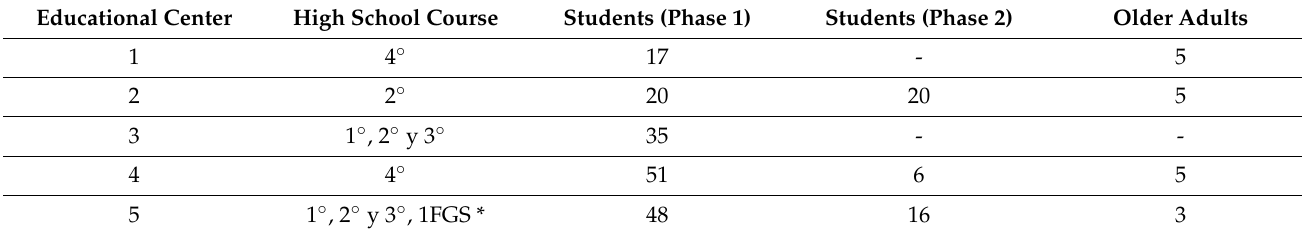
Table 2. Participants in each phase (academic year